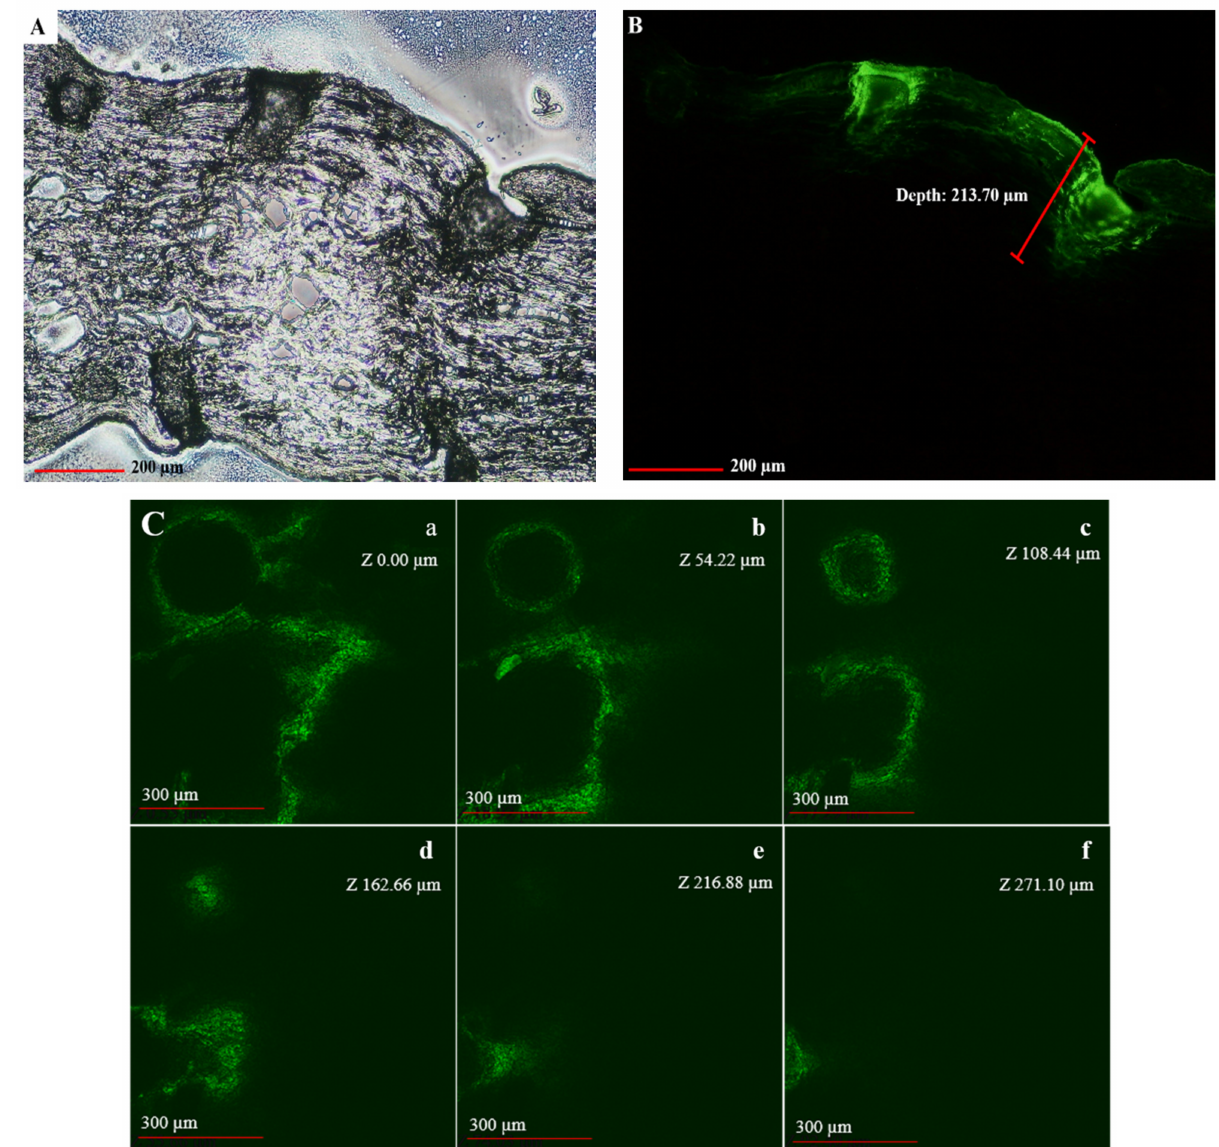
Figure 7. Depth of insertion of FLUZ-MEs-loaded two-layered dissolving MNs in corneal tissues: ( A ) bright field of cross-section image; ( B ) fluorescence of cross-section image (10 × objective lens); and ( C ) x-y plane CLSM image at difference penetration depths inside the corneal tissue: ( a ) 0.00 µ m, ( b ) 54.22 µ m, ( c ) 108.44 µ m, ( d ) 162.66 µ m, ( e ) 216.88 µ m and ( f ) 271.10 µ